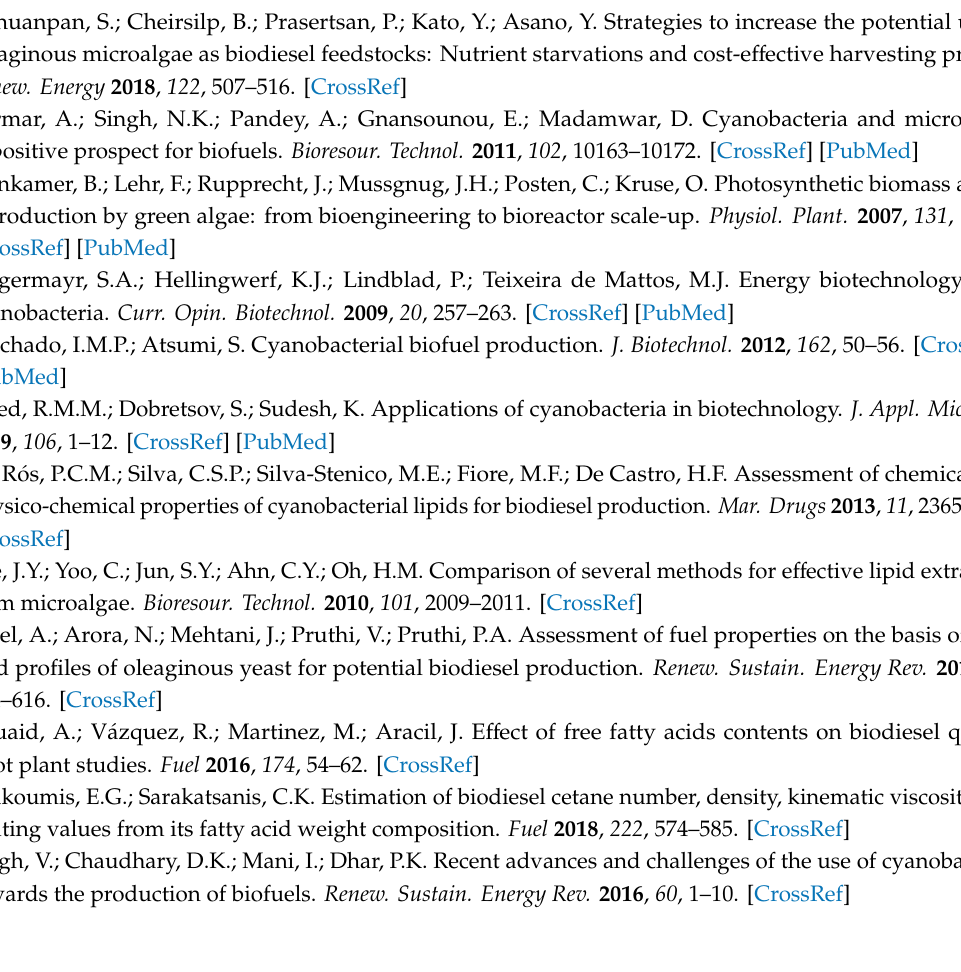
level. Table S3: Analysis of variance (ANOVA) for the biomass productivity response variable (mg / L / day) of Pantanalinema rosaneae CACIAM18, at the 95% confidence level. Table S4: Analysis of variance (ANOVA) for the Table S5: Analysis of variance (ANOVA) for the lipid content response variable (%) of Synechocystis sp. CACIAM05, at the 95% confidence level. Table S6: Analysis of variance (ANOVA) for the lipid content response variable (%) of Microcystis aeruginosa CACIAM08, at the 95% confidence level. Table S7: Analysis of variance (ANOVA) for the lipid content response variable (%) of Pantanalinema rosaneae CACIAM18, at the 95% confidence level. Table S8: Analysis of variance (ANOVA) for the lipid content response variable (%) of Limnothrix sp. CACIAM25, at the 95% confidence